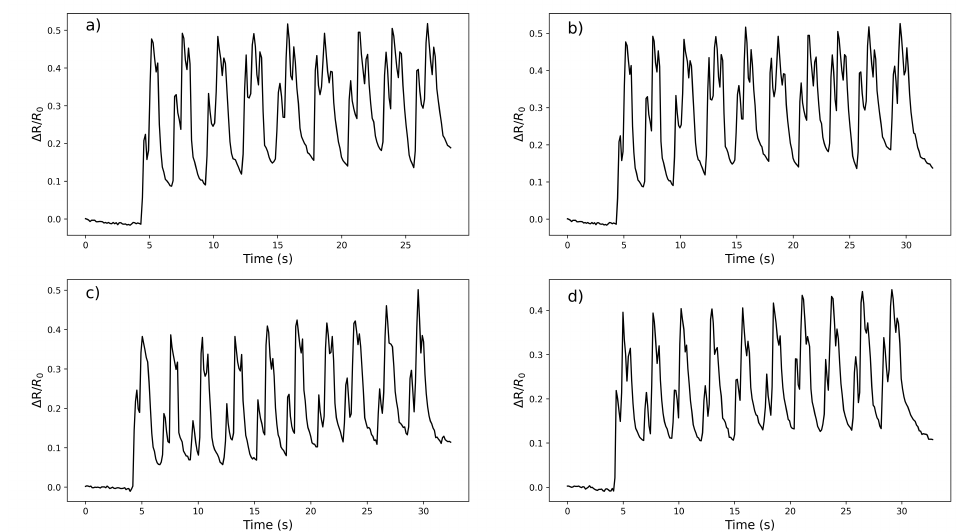
Figure 6. The performance of the Version 1 sensor in four different trials with repeated finger movements 0–45–90 degrees: ( a ) 1.test, ( b ) 2.test, ( c ) 3.test and ( d ) 4.test.